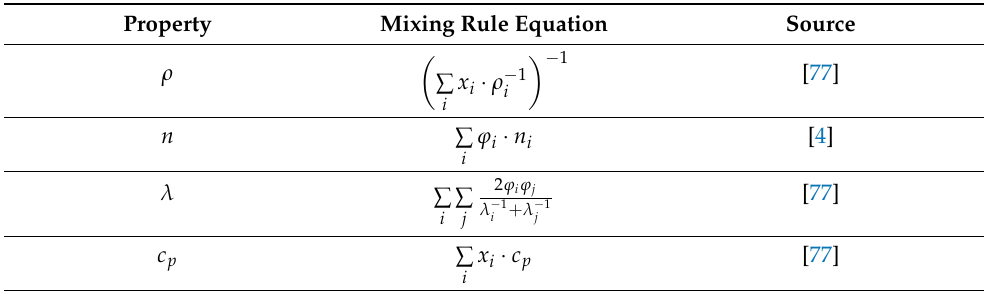
Table A4. Ideal mixing rules with x i and ϕ i denoting mass fraction and volume fraction of component i , respectively.